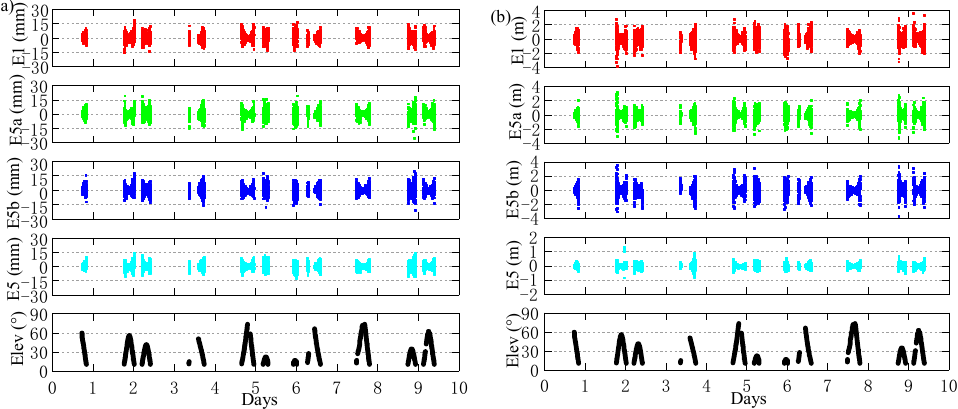
Figure 9. Phase and pseudo-range single-difference residuals of E03 satellite ( a ): Phase, ( b ): pseudo-range.